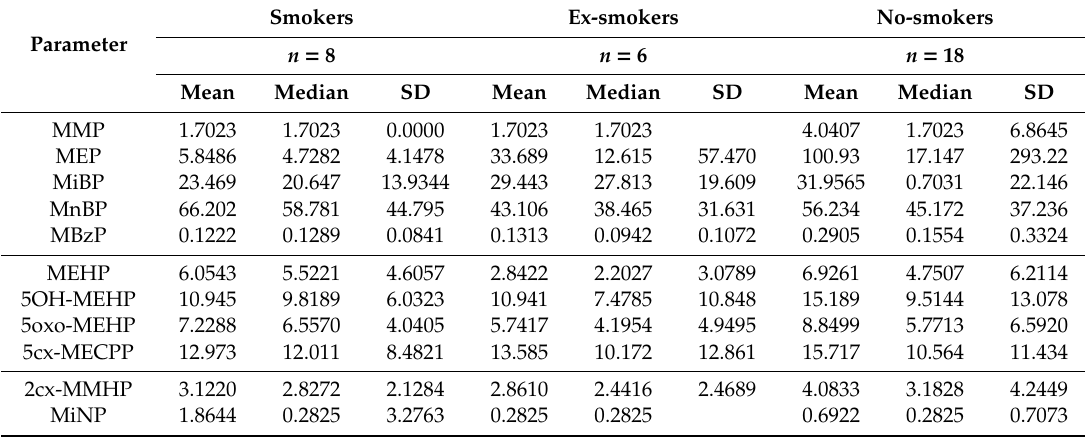
Table 6. Phthalate metabolites ( µ g / L) in the studied group divided by smoking